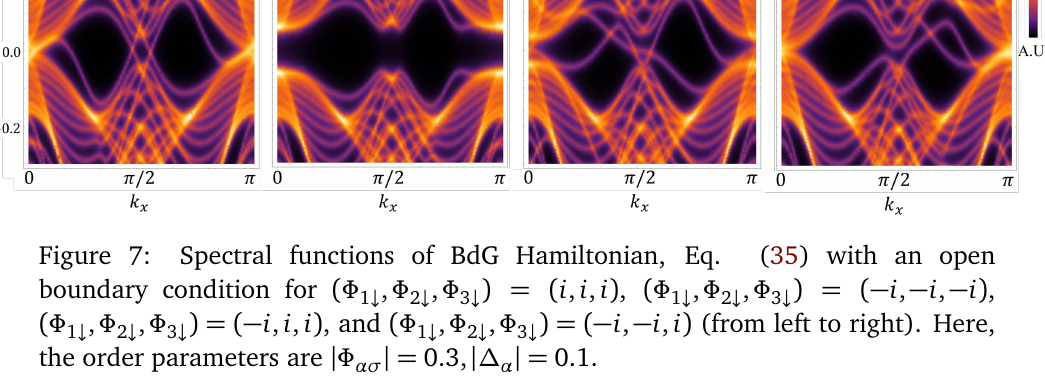
) = ( i , i , i ) , ( Φ , Φ , Φ 1 ↓ 2 ↓ 3 ↓ ) = ( − i , − i , i ) (from left to right). Here, , Φ , Φ 1 ↓ 2 ↓ 3 ↓